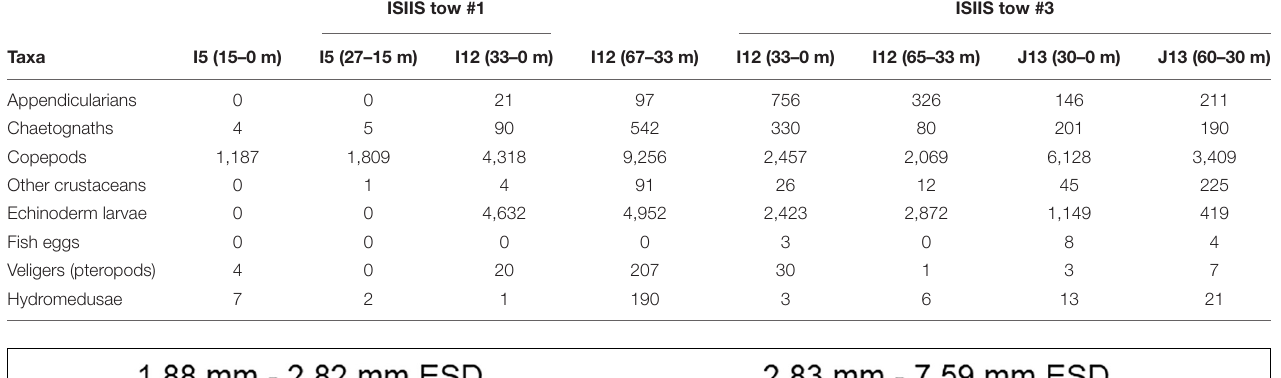
TABLE 2 | Detected concentrations for plankton collected in the vertical net samples (ind. m − 3 ) at the beginning and end of the ISIIS tows #1 and #3. ISIIS tow #1 ISIIS tow #3